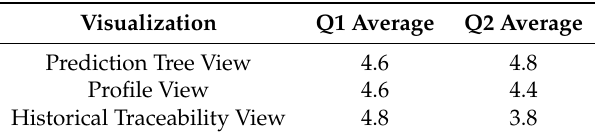
Table 1. Research questions